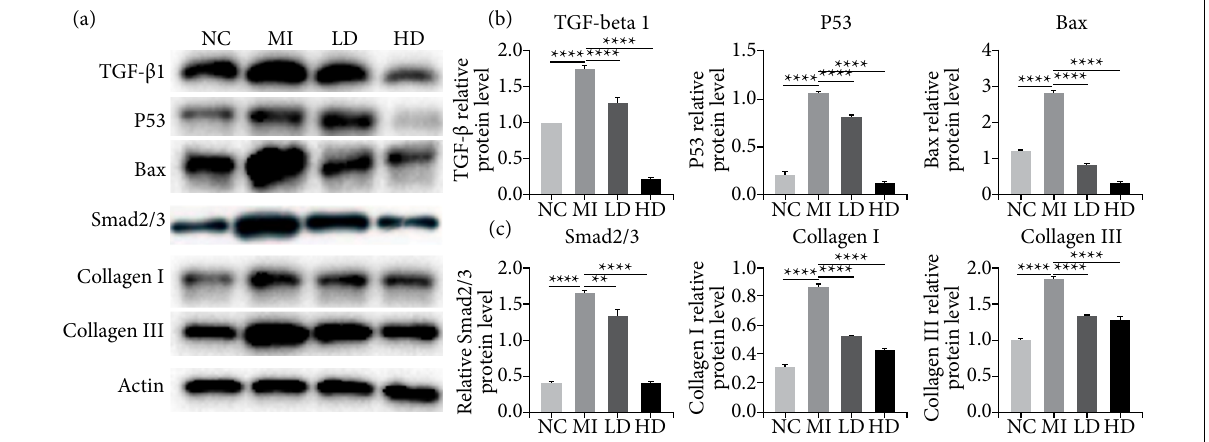
Figure 5 - Role of jatrorrhizine on expressions of TGF- β 1/Smad2/3 and p53 in mice. MI led